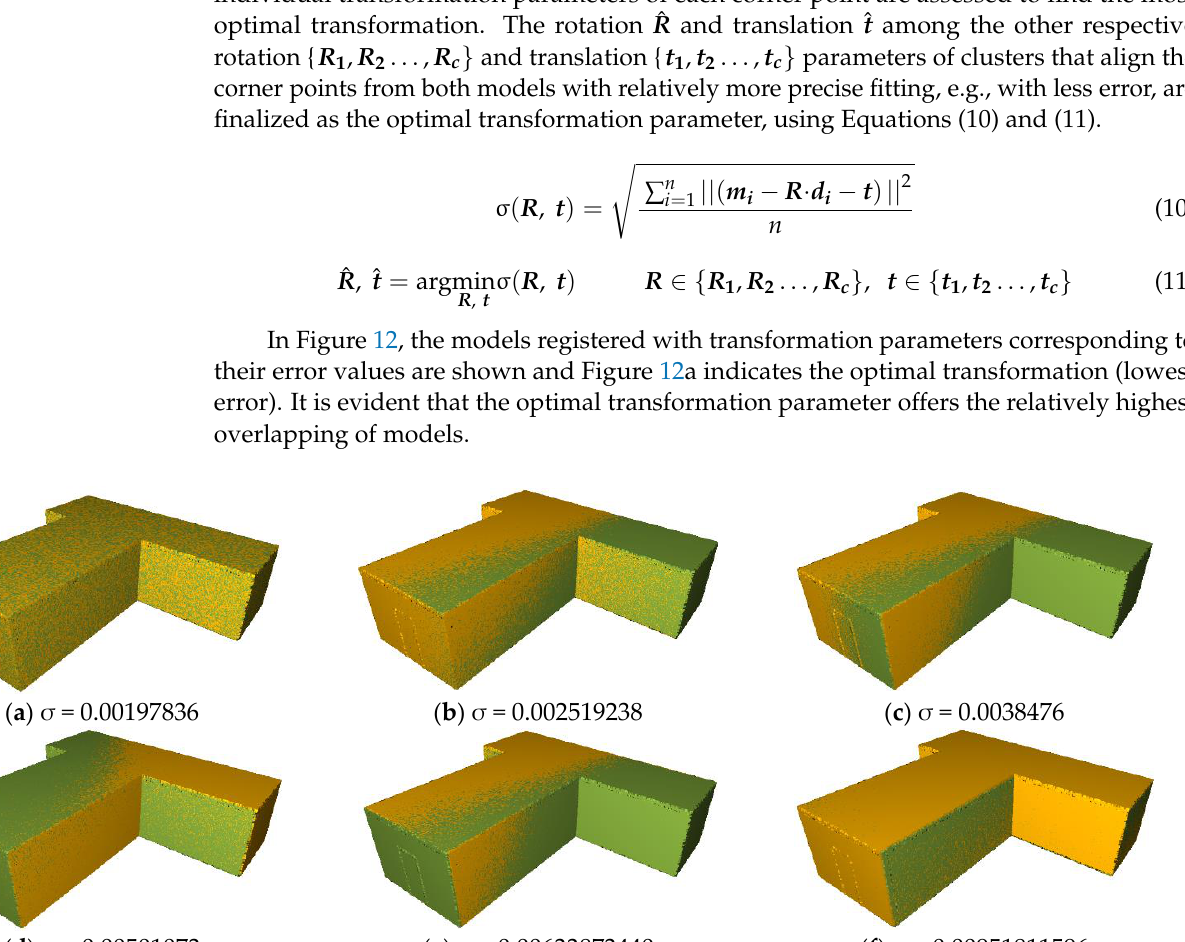
Figure 11 . Visualization of the corner points from the as-built (yellow) and transformed as-planned model (green) resulting in aligned corner points (blue) according to each cluster transformation ( a – c ).